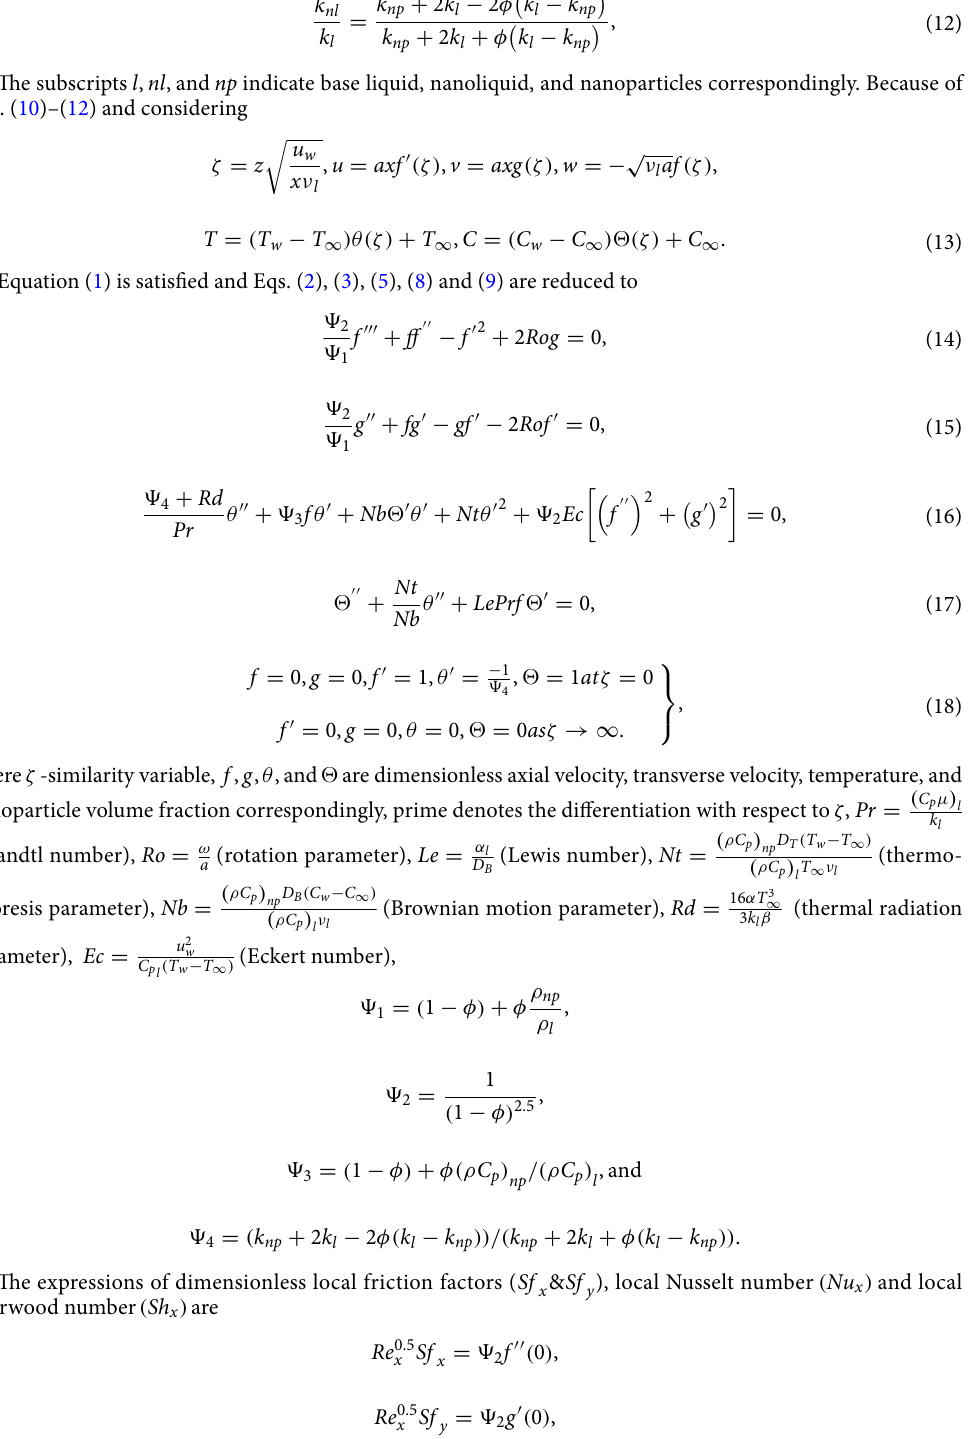
The subscripts l , nl , and np indicate base liquid, nanoliquid, and nanoparticles correspondingly. Because of